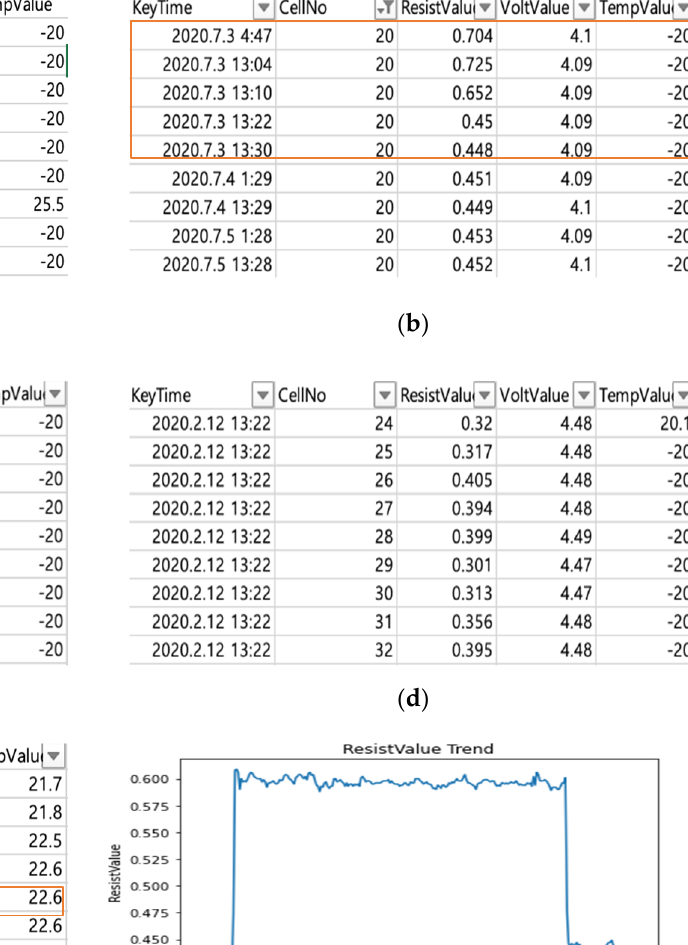
Figure 2. Steps for data preprocessing . ( a ) Step 1. Delete KeyTime(DateTime) error; ( b ) Step 2. De-